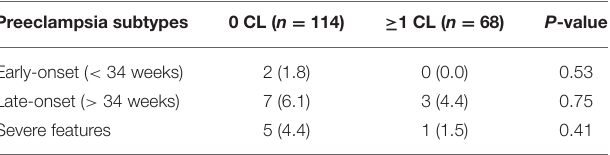
TABLE 3 | Preeclampsia subtypes in singleton birth after frozen-thawed embryo transfer in the absence (0 CL) or presence ( ≥ 1 CL) of a corpus luteum a . Preeclampsia